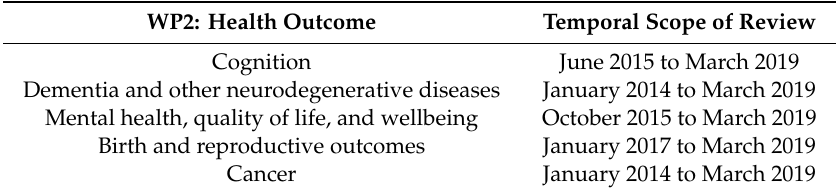
Table 1. Summary of health outcomes and temporal scope for the systematic